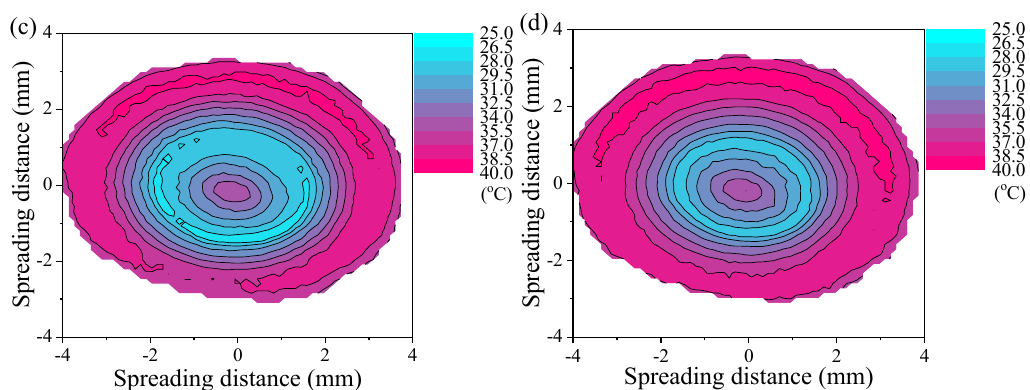
Figure 7. Temperature distribution and evolution of droplet impact on the superhydrophilic surface at ( a ) t = 20 ms, ( b ) t = 40 ms, ( c ) t = 60 ms, and ( d ) t = 80 ms. Experimental conditions: W e = 7.6, T w = 40.0 °C. 0 represents the impact center.